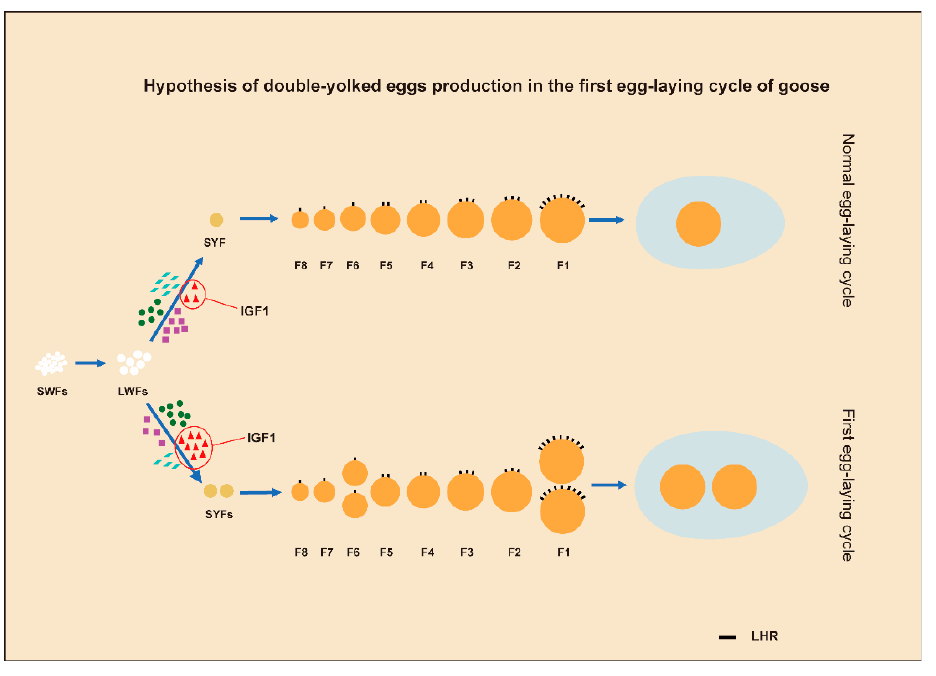
Figure 7. A schematic model of proposed roles of IGF1 and LH signals in producing double- yolked eggs.